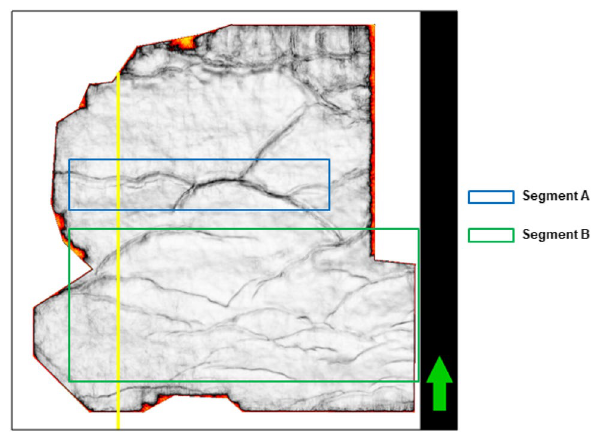
Fig. 13 Study area segments used for fault dynamics